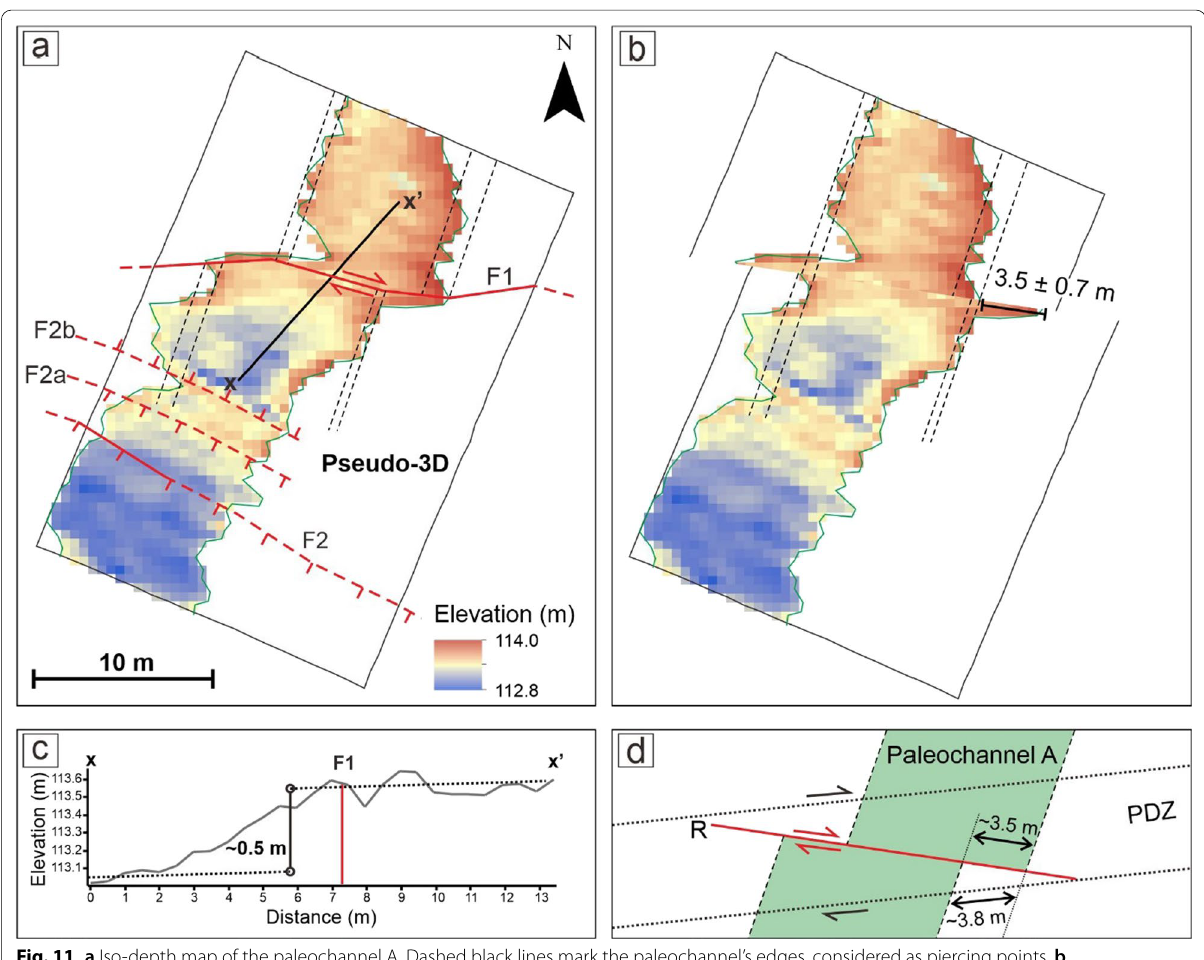
Fig. 11 a Iso-depth map of the paleochannel A. Dashed black lines mark the paleochannel’s edges, considered as piercing points. b Back-projection of the paleochannel A. c Longitudinal profile of the base of the paleochannel A across the F1 fault. Dotted black lines indicate the reference for the vertical displacement calculation. d Schematic diagram showing the estimation of the horizontal offset amount on the